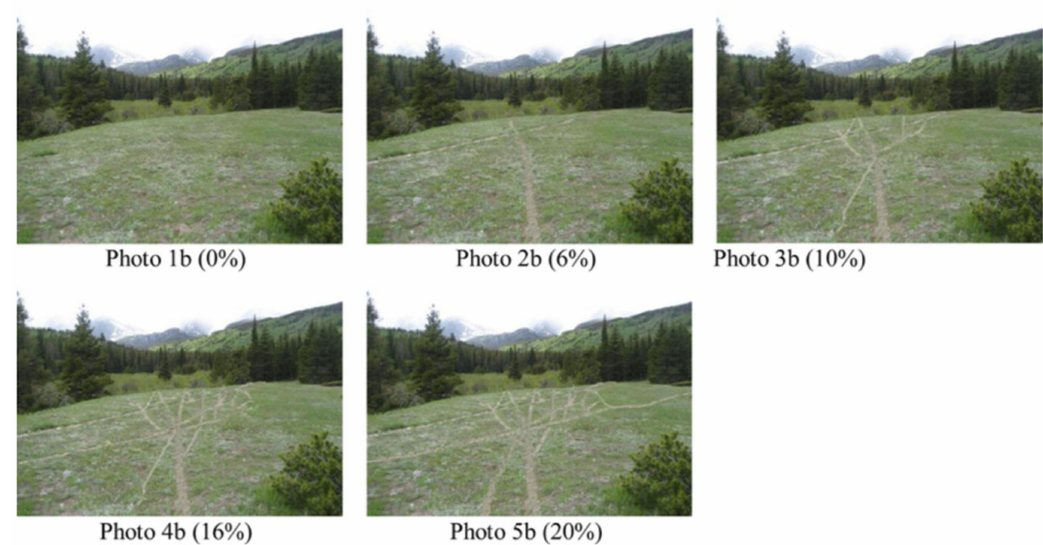
Figure 1. Meadow scenes with increasing visitor-created social trails. Percentiles represent the percent of the area impacted by social trails [42].